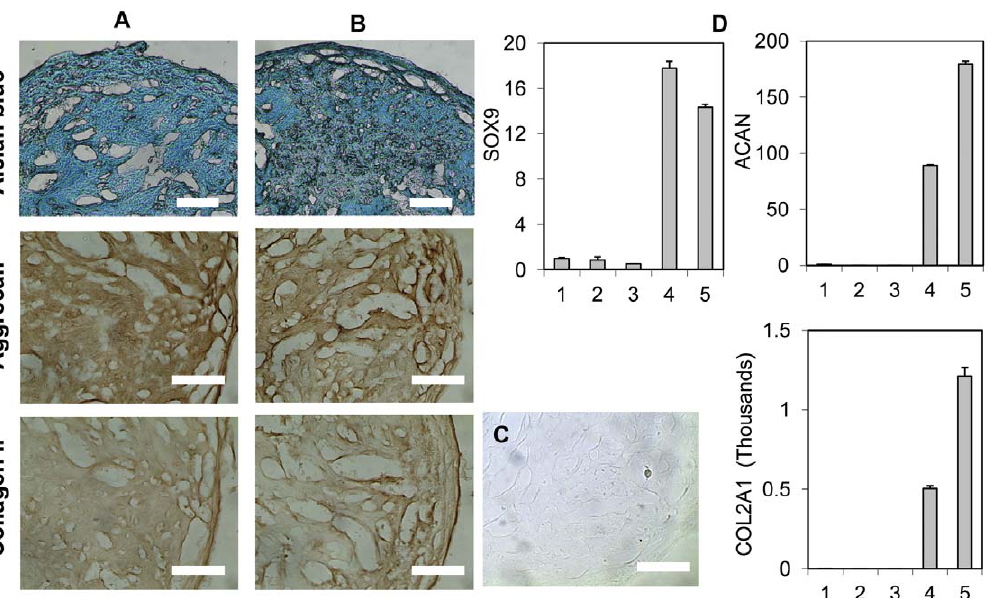
Figure 5. Invitro chondrogenic differentiation. Positive chondrogenic matrix staining observed after chondrogenic differentiation. (A) and (B) are images of 21d cultures of MSC-like cells derived from H9-hESC and YK26-iPSCs, respectively. Alcian blue staining of the histological sections of the chondrogenic pellet cultures was positive. Immunohistochemical staining for aggrecan and collagen Type II on the histological sections of the 21 d chondrogenic pellet cultures was positive. Scale bars: 0.2 mm. (C) Negative control for Col II. (D) RT-qPCR analysis for mRNA expression of chondrogenic genes including SOX9, COL2A1 and aggrecan (ACAN). 1: undifferentiated H9-hESC; 2 and 3: MSC-like cells that derived from H9-hESC and YK26-iPS cells, respectively, before chondrogenic differentiation; 4 and 5: 21 day chondrogenic cultures of the MSC-like cells derived from H9- hESC and YK26-iPS cells, respectively.